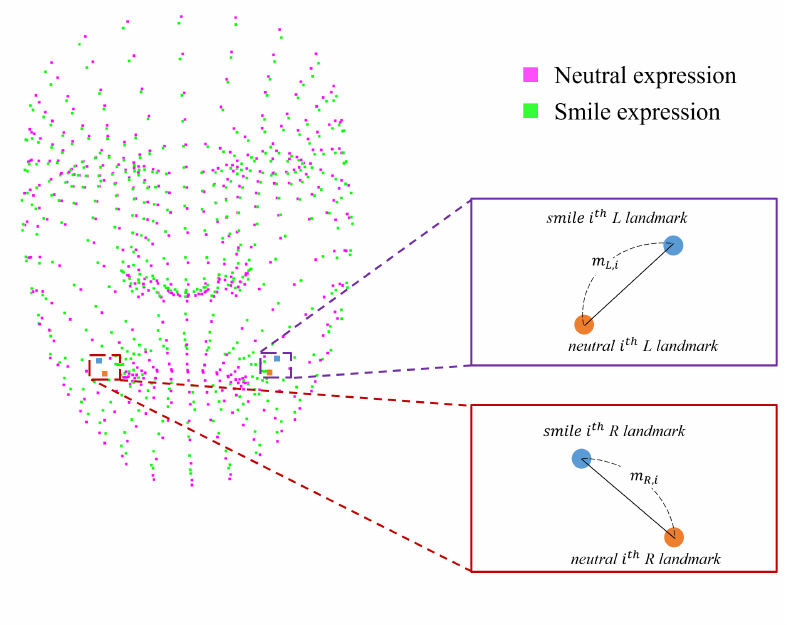
Figure 7. Amount of landmark movement determined through the distance of the landmarks corresponding to the left and right side of the face in the neutral and smile expression.